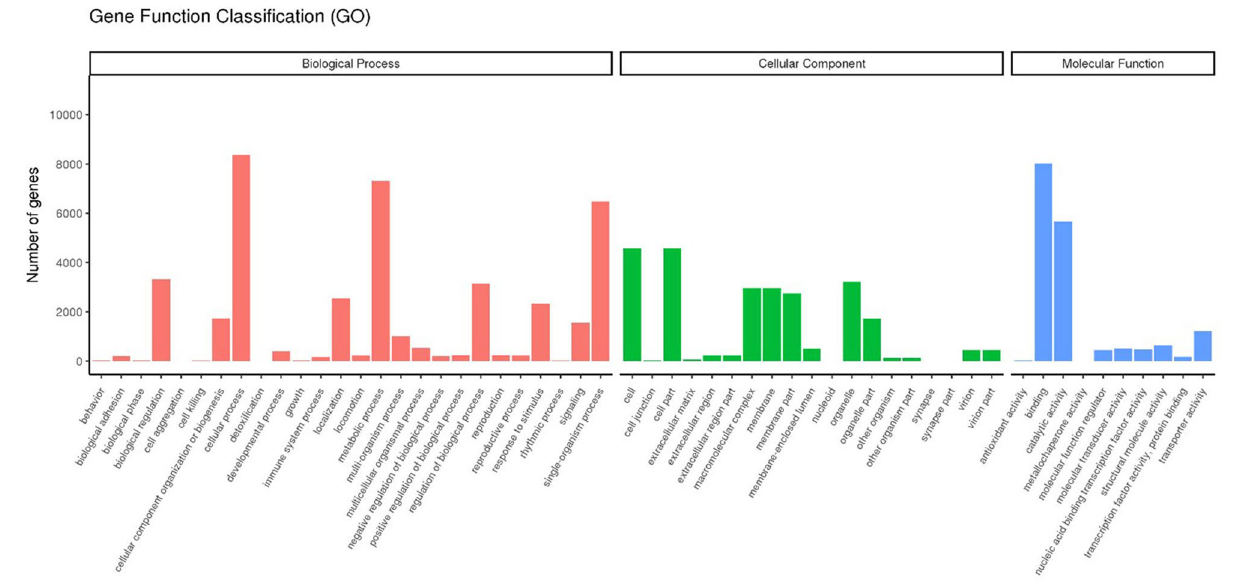
Figure 1. GO classification. The genes were summarized in three main categories: biological process (pink), cellular component (green), and molecular function (blue). The y axis represents the number of genes in the main category. GO gene